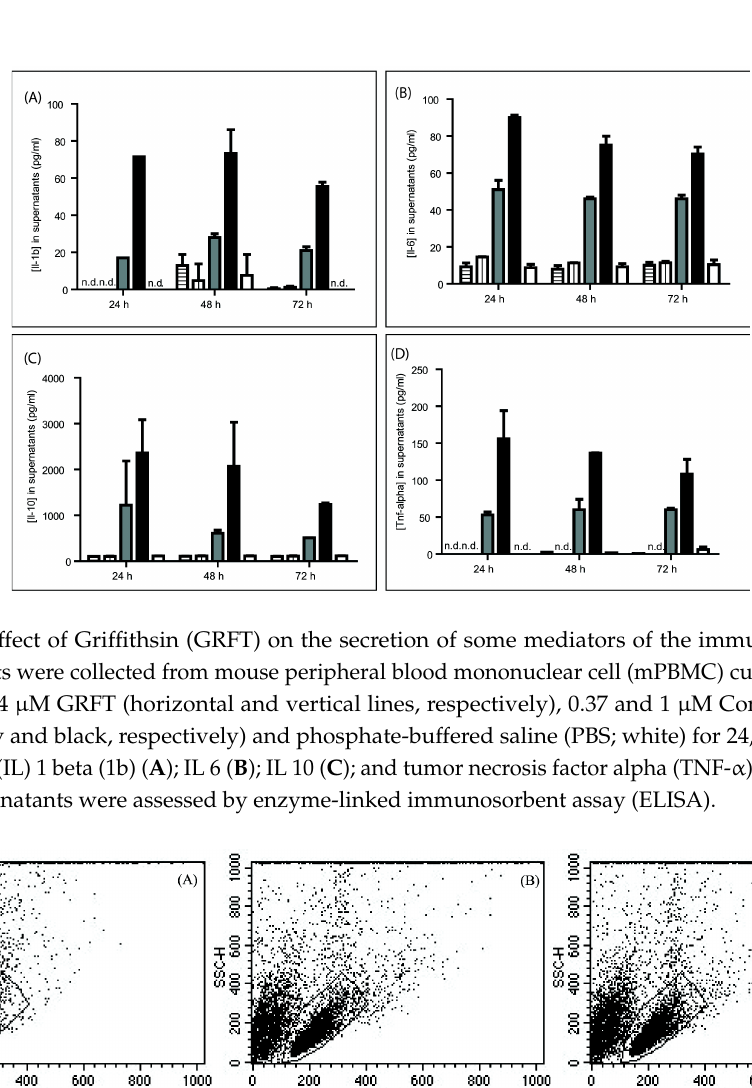
Figure 1. Effect of Griffithsin (GRFT) on the secretion of some mediators of the immune response. Supernatants were collected from mouse peripheral blood mononuclear cell (mPBMC) cultures treated with 1 and 4 μM GRFT (horizontal and vertical lines, respectively), 0.37 and 1 μM Concanavalin A (ConA; grey and black, respectively) and phosphate-buffered saline (PBS; white) for 24, 48, and 72 h. Interleukin (IL) 1 beta (1b) ( A ); IL 6 ( B ); IL 10 ( C ); and tumor necrosis factor alpha (TNF- α) ( D ) amounts in the supernatants were assessed by enzyme-linked immunosorbent assay (ELISA).